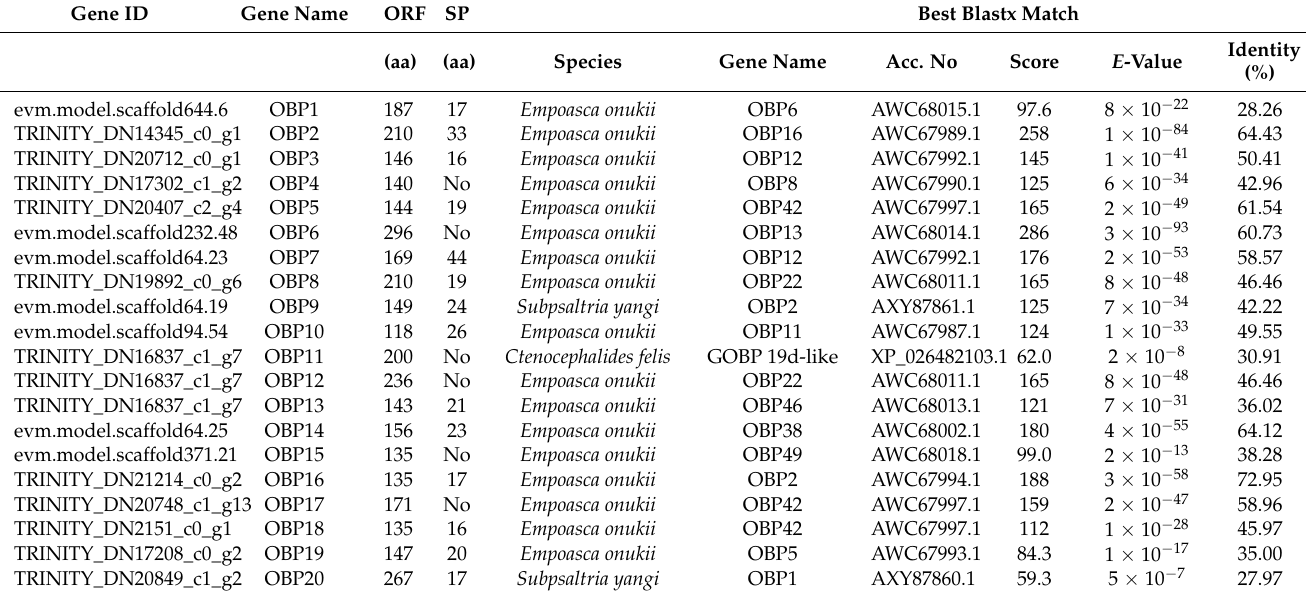
Table 1. List of identified OBP genes of N. cincticeps .